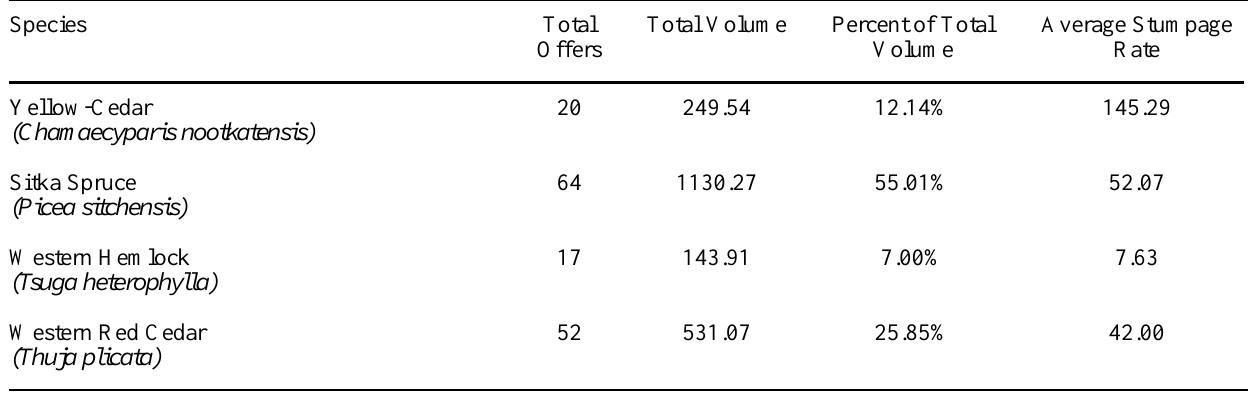
Table 1. Tongass National Forest microsale program offers, total volume, and average advertised stumpage rates, by species